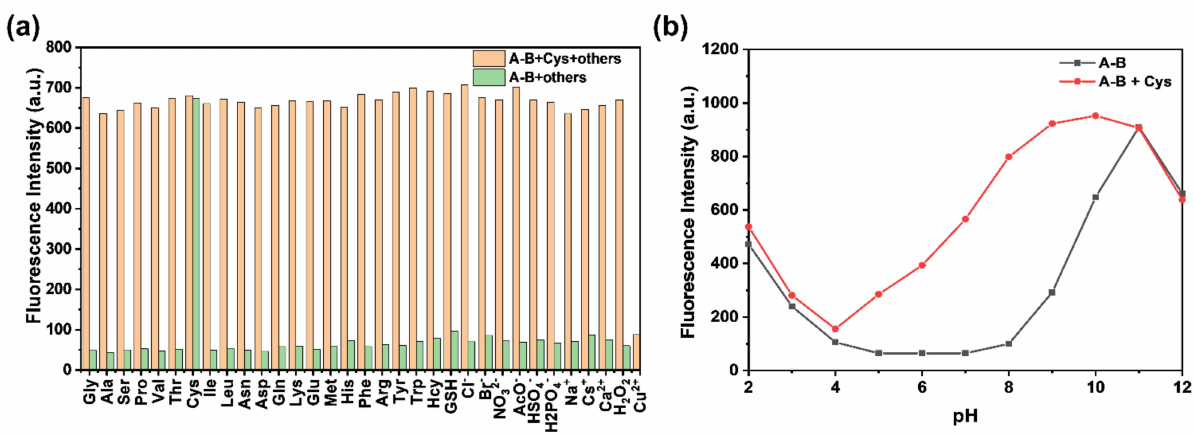
Figure 6. ( a ) Competitive study of A-B (10 µ M) with and without the addition of five equivalents of various analytes (50 µ M) in 1 mM HEPES buffer at room temperature, ( b ) effect of pH on the Cys detection (0, 50 µ M) by A-B (10 µ M) at various pH ( λ ex = 303 nm, λ em = 350